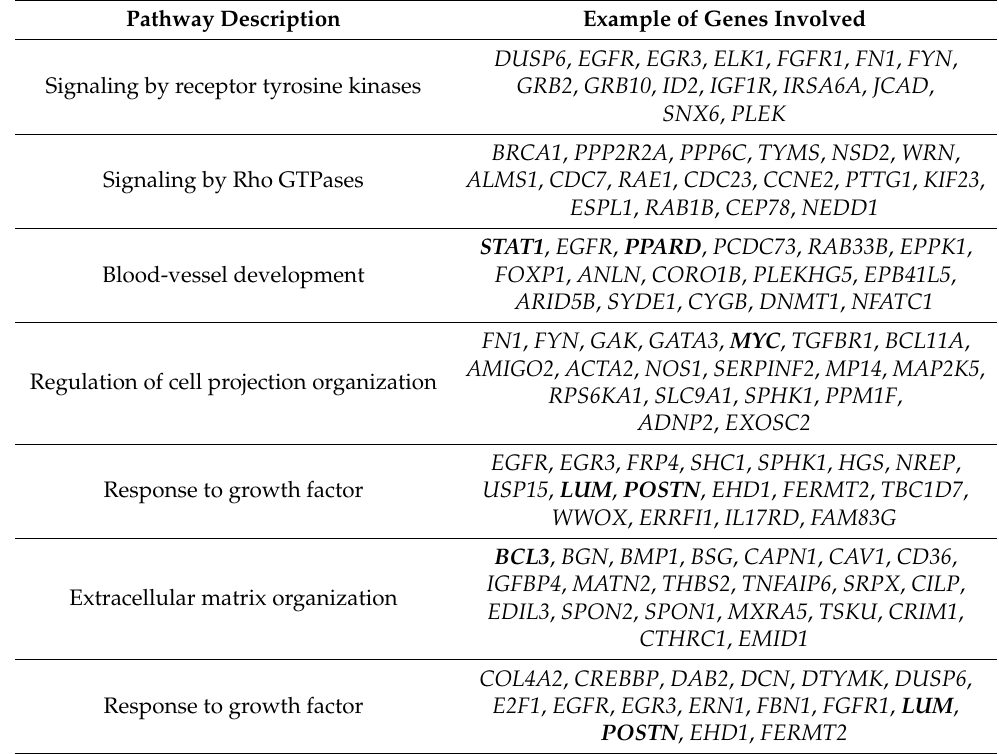
Figure 6. Venn diagram showing common pathways and genes among lung cancer patients and severe asthmatics. ( A ) Common pathways between asthmatics and lung cancer patients from Metascape analysis. ( B ) Commonly upregulated genes between asthmatics and lung cancer groups. Common pathways occurring between Metascape and GSEA analysis for ( C ) severe asthmatics and ( D ) lung cancer patients. Table 8. Main pathways and their genes from the upregulated functional clusters (analyzed with Metascape) in lung cancer patients versus healthy controls. The genes represented in bold indicate an overlap with the asthma